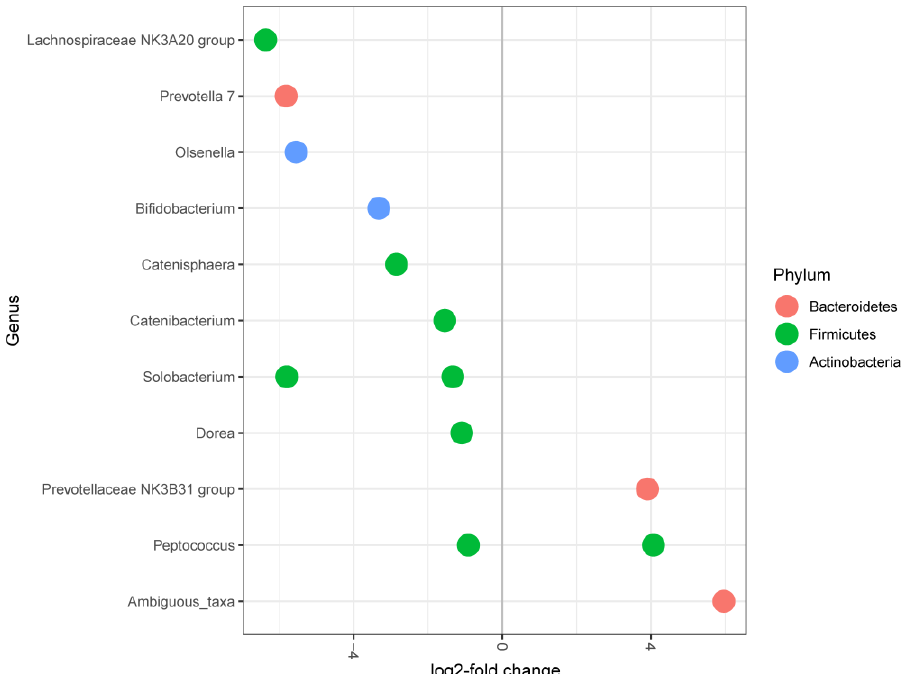
Figure 6. DESeq2 analysis of differentially abundant OTUs (significance threshold for alpha < 0.01) of piglets with Salmonella counts above versus below 3.2 log 10 CFU/g cecal content. Each point represents a single OTU grouped by genus and by color according to which taxonomic phylum the OTU originates from.